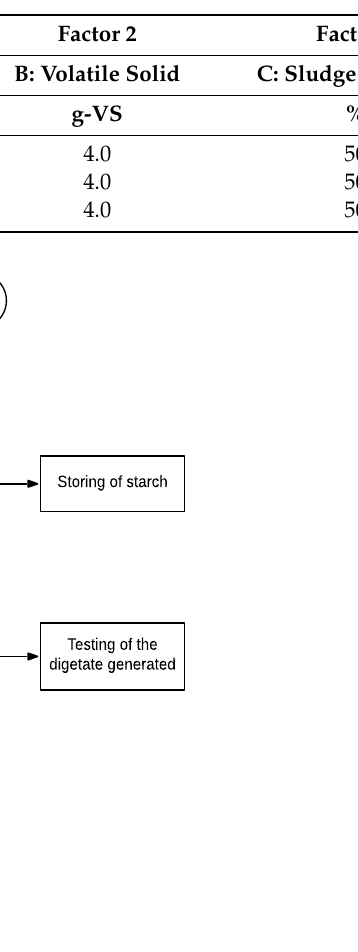
Table 2. Control sample conditions.